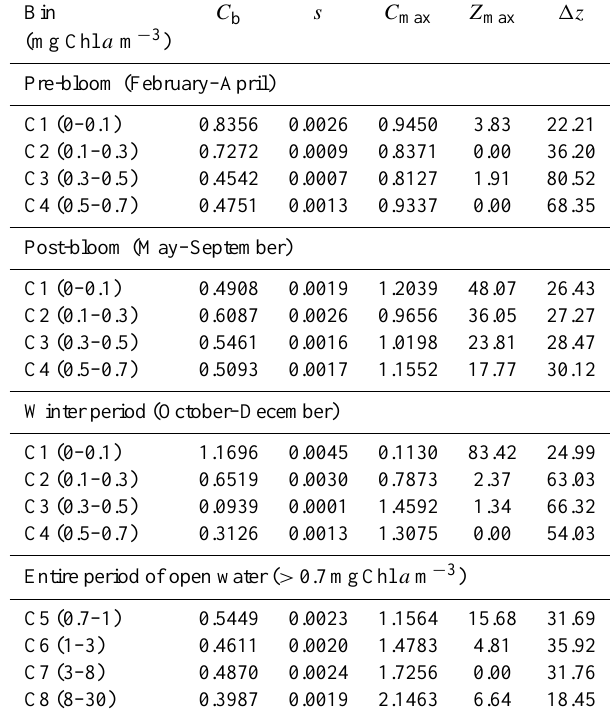
Table 3. Estimated values of the five parameters of Equation 1, obtained for the average dimensionless vertical profiles of chloro- phyll a (C1–C8) during different time periods (i.e., pre-bloom, post- bloom, winter and entire period of open water > 0.7mgm − 3 ) at deep ( > 50m) Arctic